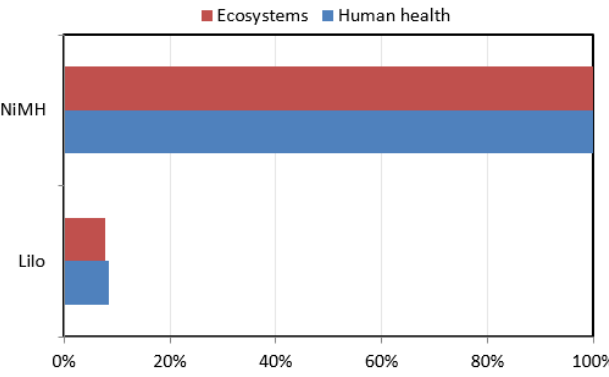
Figure 10. LCA outcome comparison of LiIo and NiMH batteries by the ReCiPe endpoint